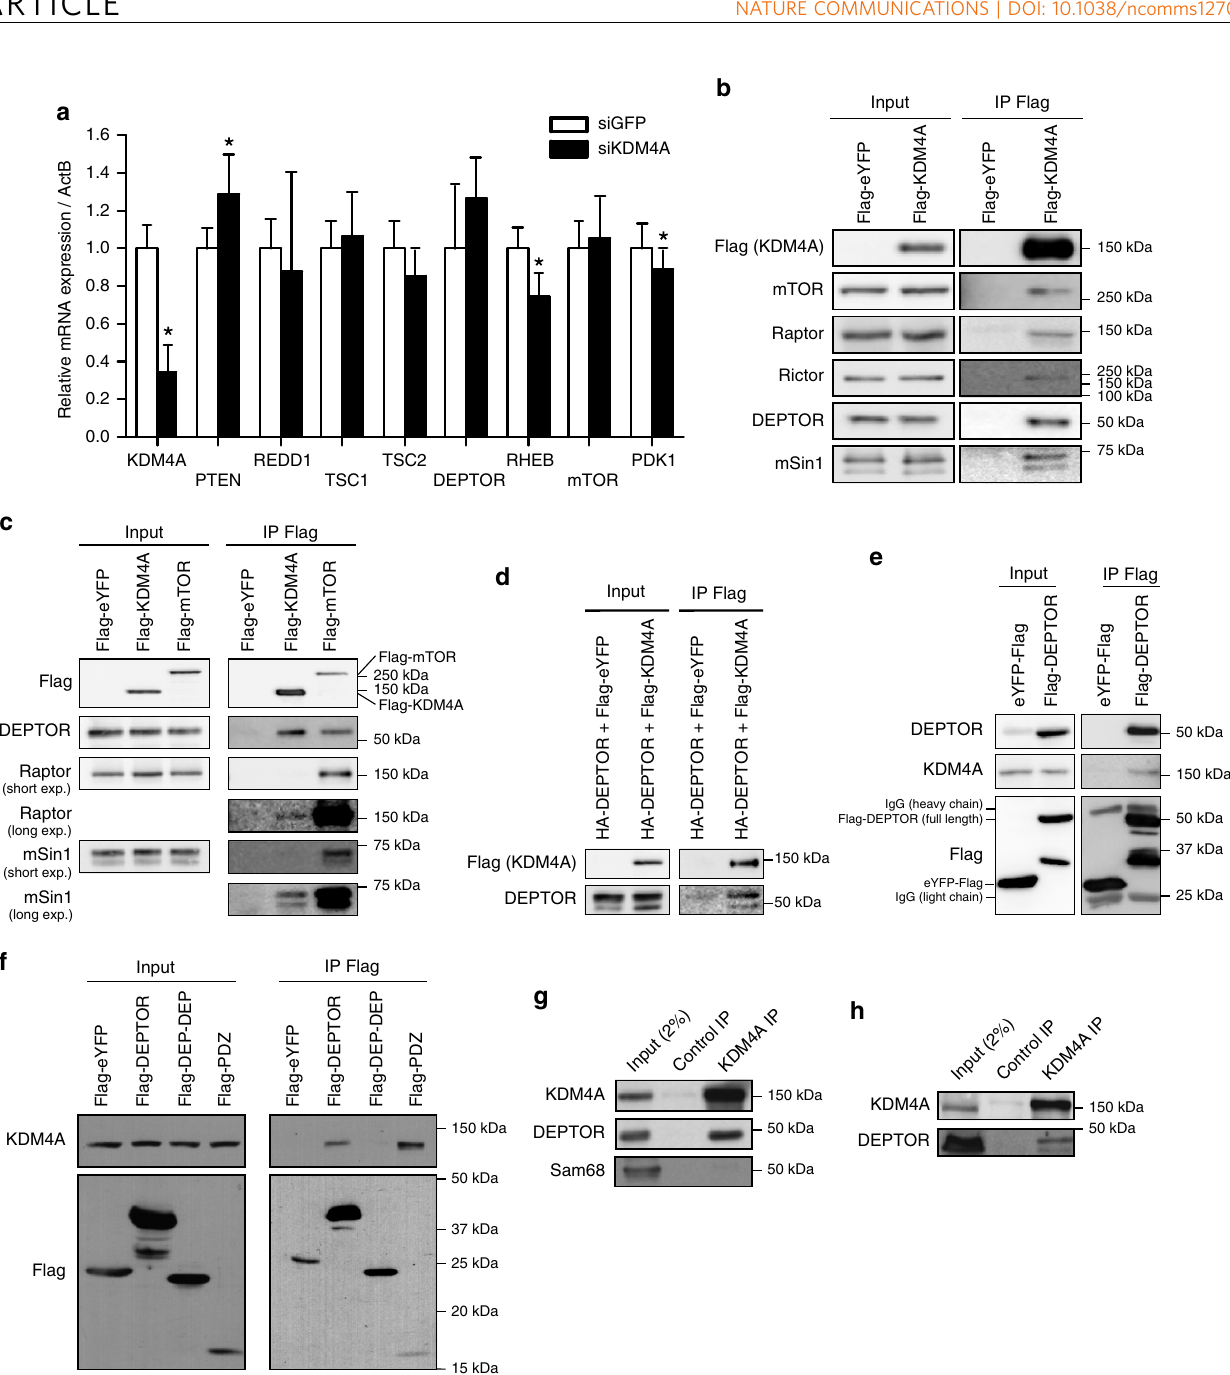
Figure 3 | KDM4A interacts with the mTORC1/2 complex. ( a ) Relative mRNA levels of negative and positive regulators of the PTEN/AKT/mTOR pathway following KDM4A depletion. Quantifications of mRNAs by RT–qPCR were normalized against b -actin ( ActB ) mRNA. Asterisks denote a statistical difference between siKDM4A-treated cells and siGFP control cells, two-sided t -test P o 0.05 (graph represents two independent experiences). Error bars represent standard deviation. ( b ) Co-immunoprecipitation of endogenous mTORC1/2 complex members with Flag-KDM4A in 293T transfected cells. ( c ) Comparison of mTORC1/2-associated proteins with Flag-tagged mTOR or KDM4A. The 293T cells were transfected with either Flag-eYFP, Flag- KDM4A or Flag-mTOR, and protein lysates were subjected to anti-Flag immunoprecipitation. ( d ) Co-immunoprecipitation of Flag-KDM4A and HA-DEPTOR in 293T cells. ( e ) Endogenous KDM4A co-immunoprecipitates with Flag-DEPTOR. ( f ) DEPTOR PDZ domain associates with